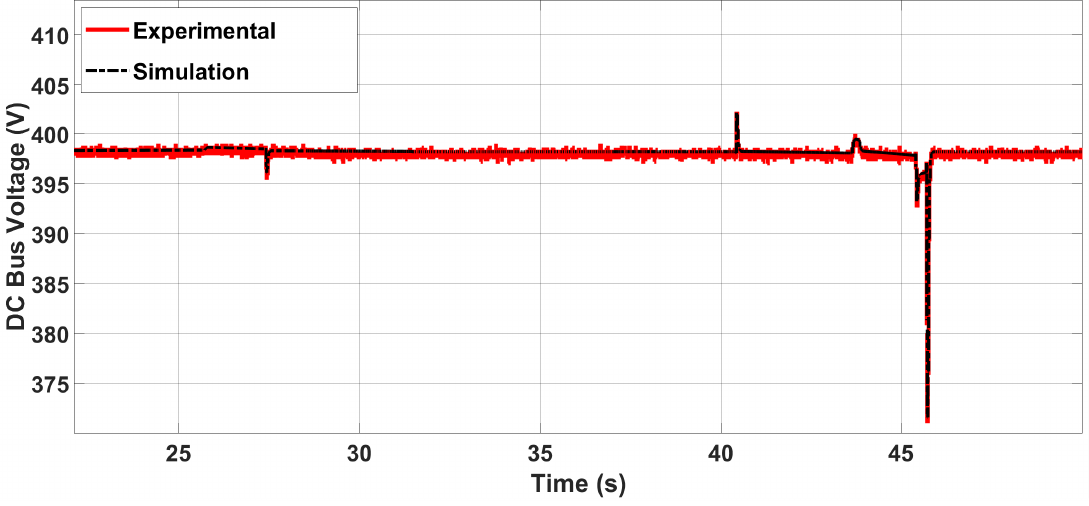
Figure 11. DC bus